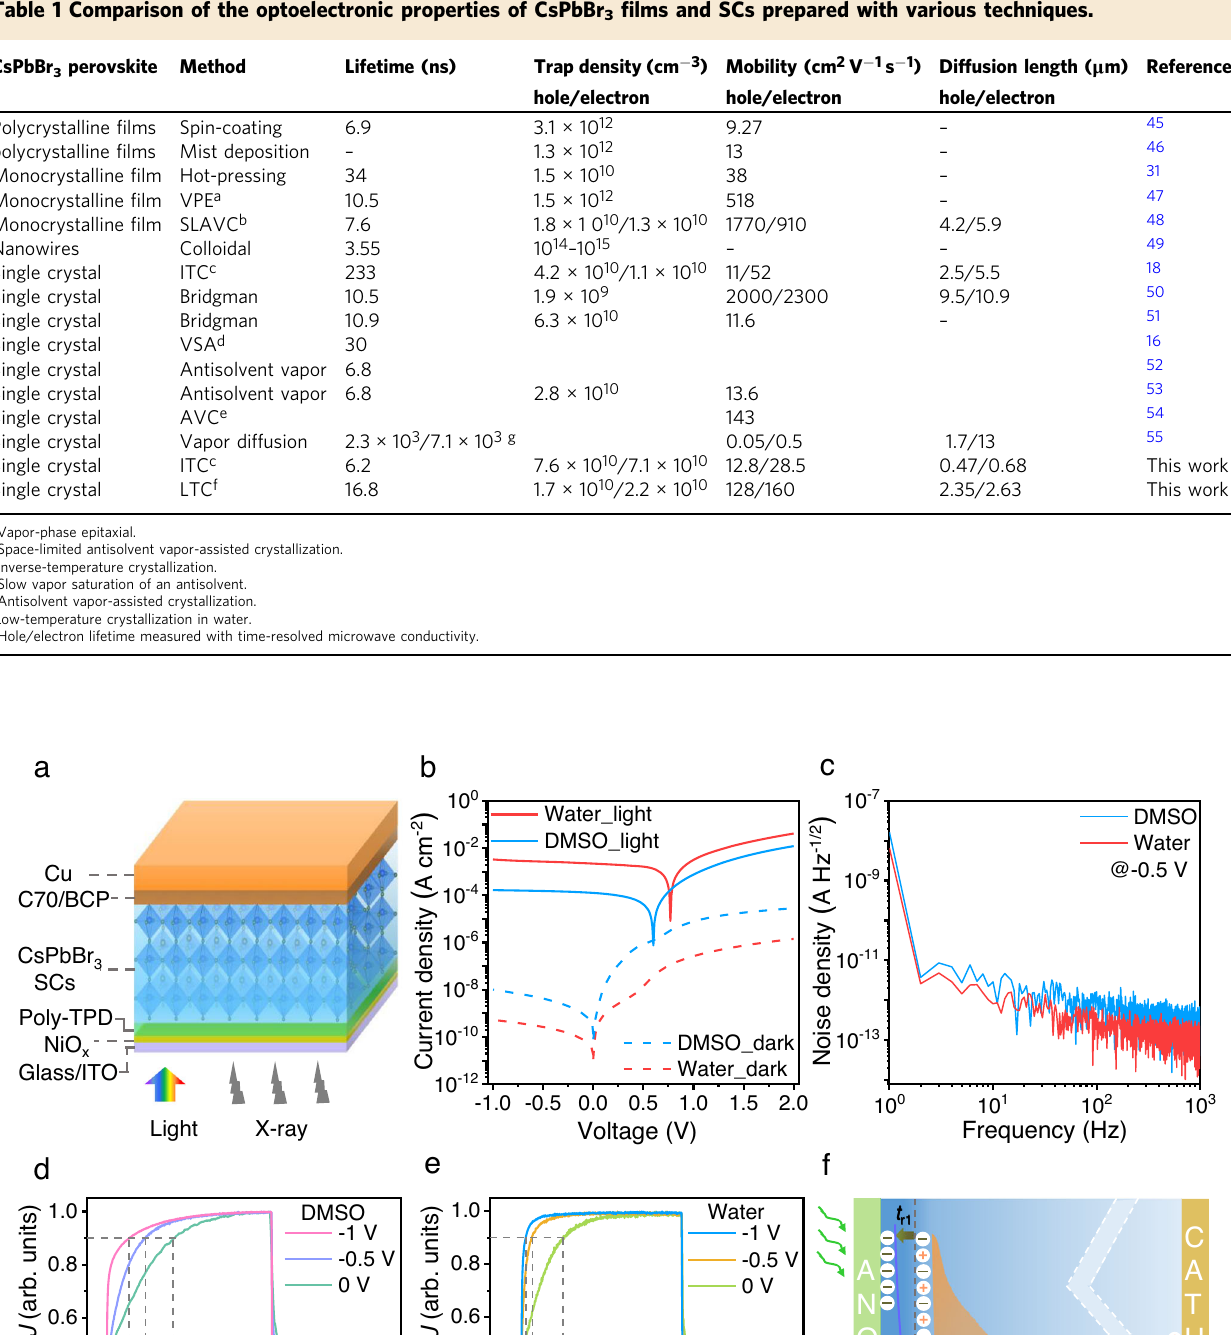
Table 1 Comparison of the optoelectronic properties of CsPbBr 3 fi lms and SCs prepared with various techniques.